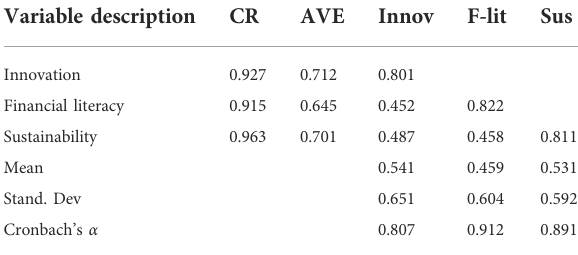
TABLE 3 Descriptive statistics and variable ’ s correlation matrix with AVE and CR model. Variable